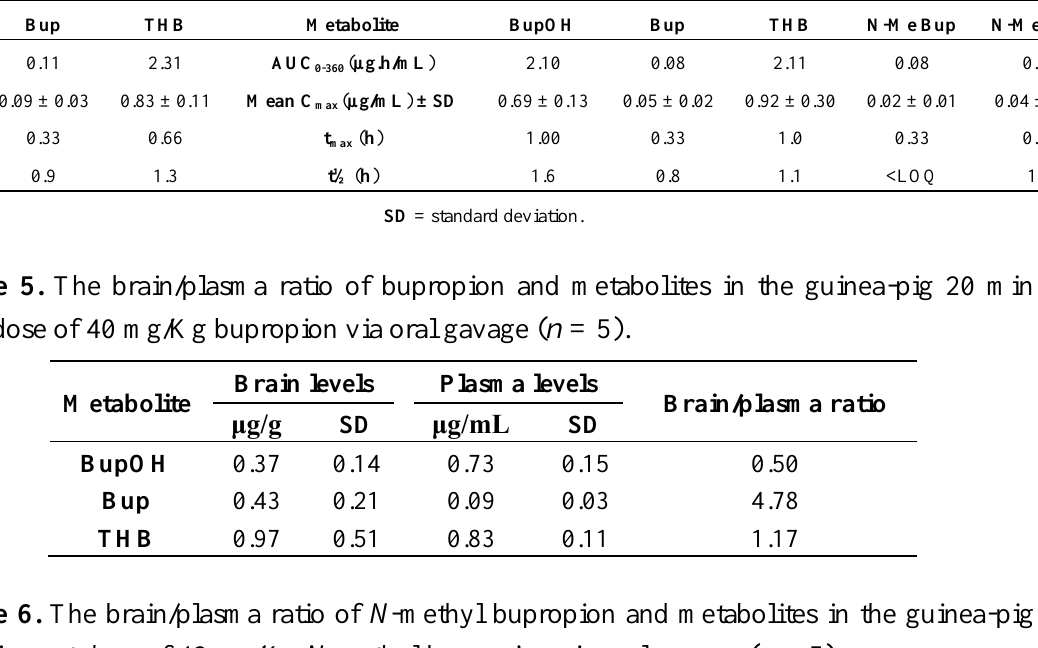
Table 6. The brain/plasma ratio of N -methyl bupropion and metabolites in the